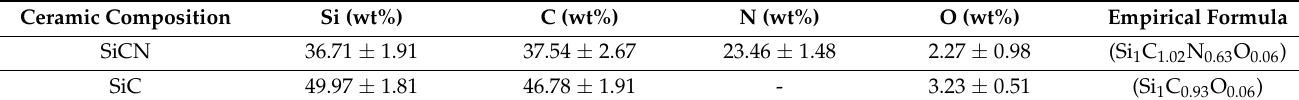
Table 2. Elemental composition of the 3D ceramics (wt%).